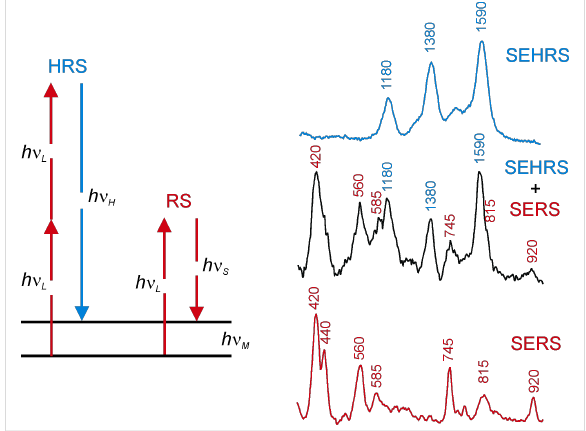
Figure 4: Schematic of hyper Raman- and Raman scattering (left) and surface enhanced Raman- and hyper Raman spectra of crystal violet on silver nanoaggregates (right, excitation 850 nm, 10 7 W/cm 2 ) . SEHRS and SERS signals of crystal violet measured in the same spectrum by simultaneously using the first and second diffraction order of the spectrograph (middle trace). In the upper and the lower trace, SEHRS and SERS spectra are differentiated by placing a NIR absorbing filter in front of the spectrograph or by switching off the mode locked regime of the Ti:sapphire laser, respectively [44]. Reprinted with permission from [22], Copyright 2006 American Chem- ical